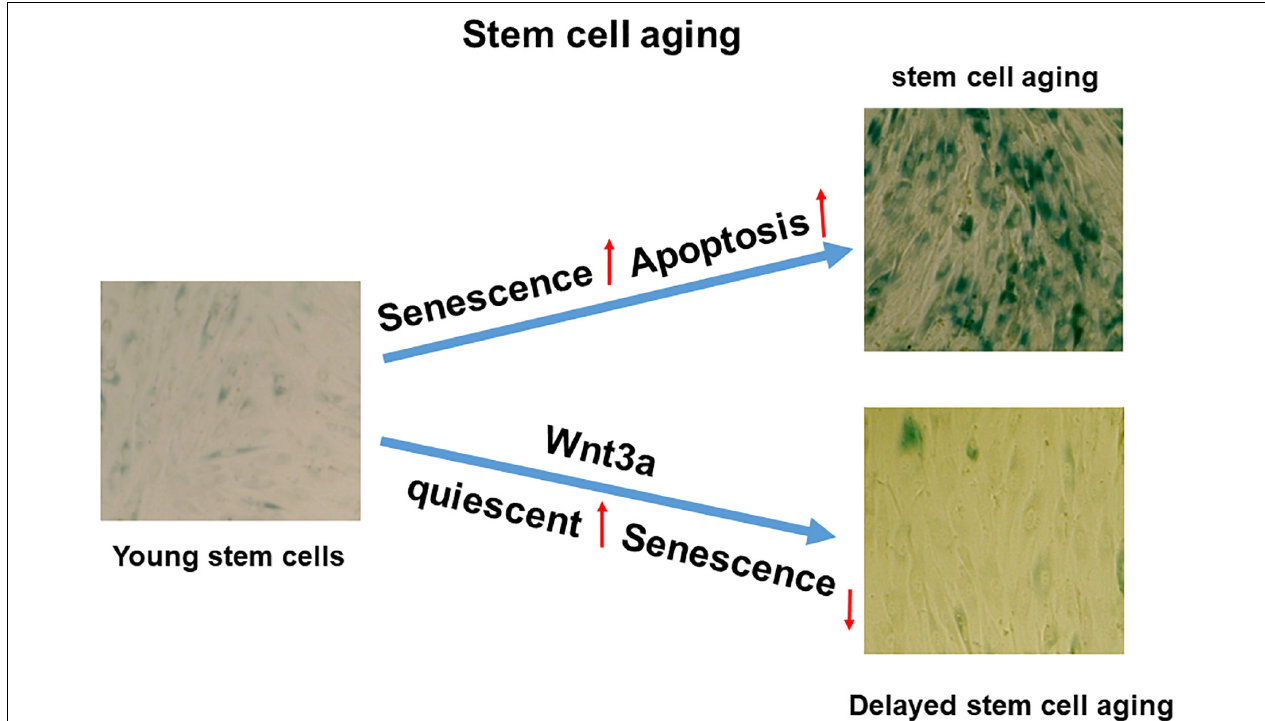
FIGURE 6 | Proposed working model in cell sheet culture-induced stromal cell aging. High-density cell sheet culture induces stromal cell aging via senescence and apoptosis pathways, while Wnt signaling activation by Wnt3a prevents cell entering senescence by switching to quiescent